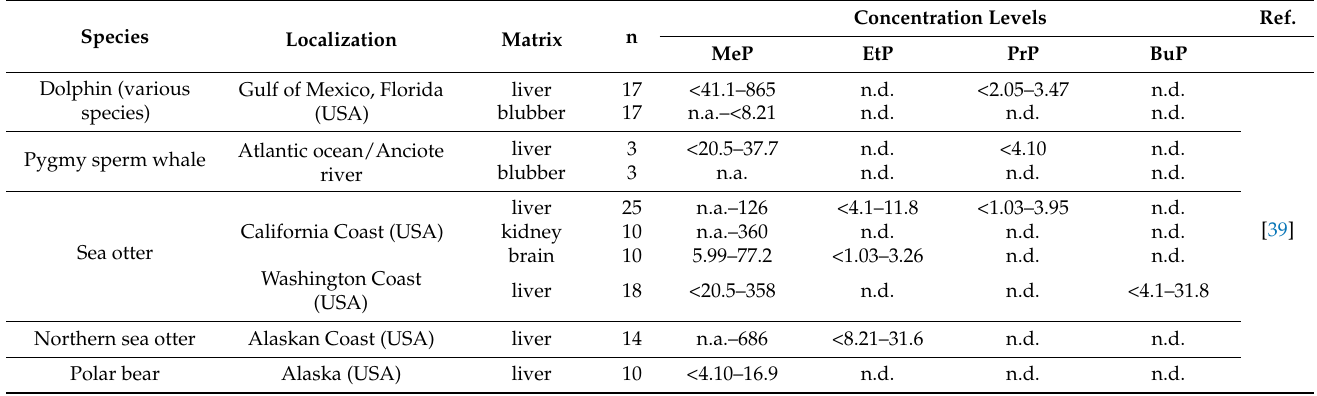
Table 5. Selected previous studies on paraben concentration levels in wild animals. Paraben concen- tration levels are shown in ng/g (in solid matrices) or ng/mL (in liquid